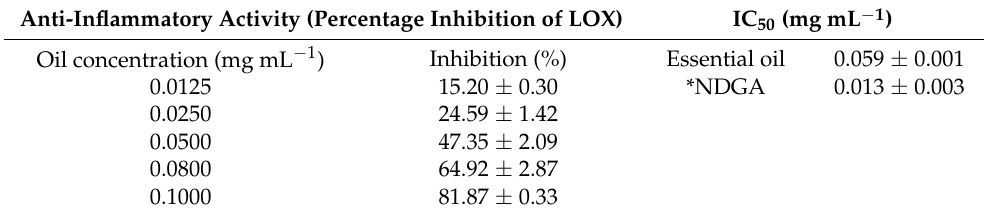
Table 5. In vitro anti-inflammatory activity of Neuropeltis acuminata leaf essential oil. Anti-Inflammatory Activity (Percentage Inhibition of